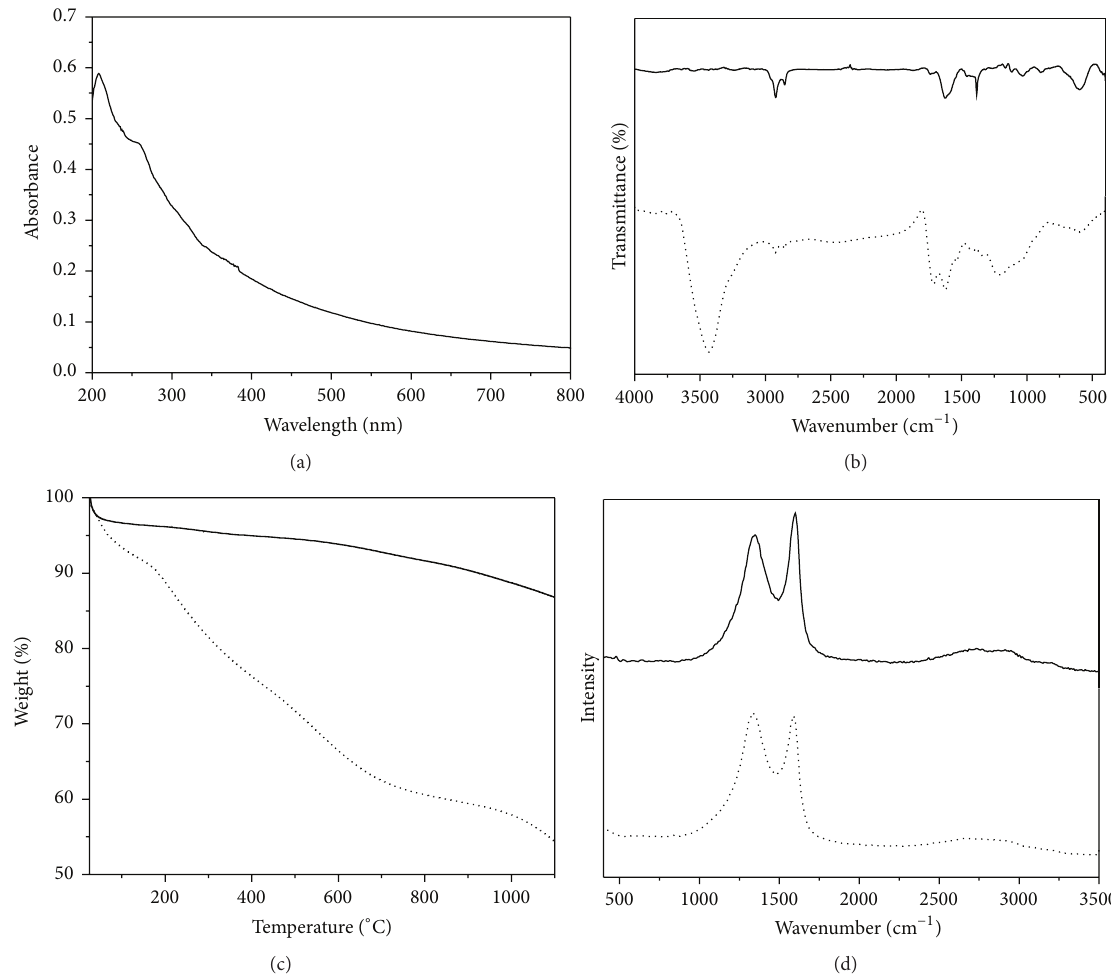
Figure 2: (a) Absorption spectra of wsCNRs in aqueous solution; (b) FTIR spectra of CNRs (solid line) and wsCNRs (dotted line); (c) TGA analysis of CNRs (solid line) and wsCNRs (dotted line) up to 1100 ∘ C; (d) Raman spectra of CNRs (solid line) and wsCNRs (dotted line).